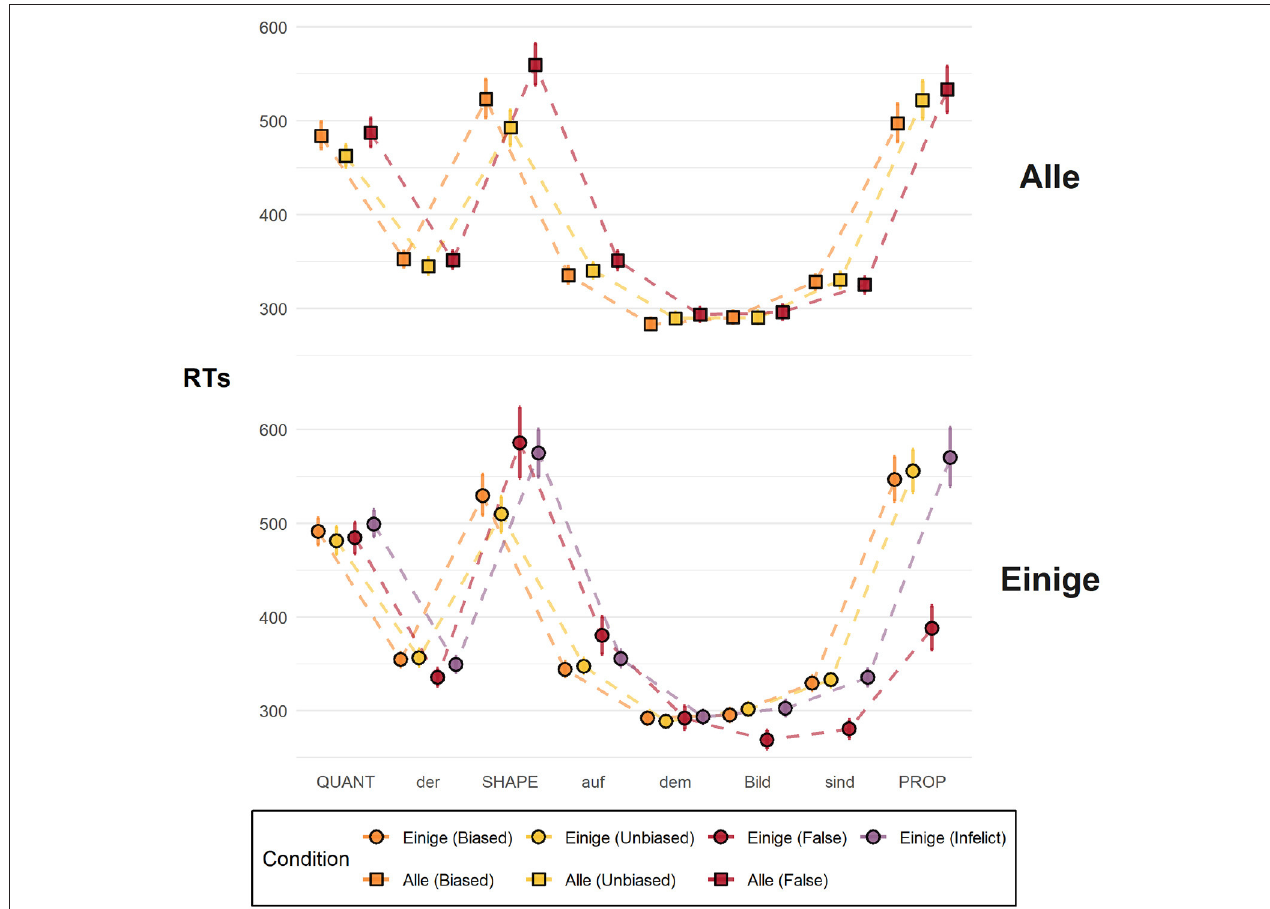
FIGURE 7 | Mean reading times across all sentence regions up until the last critical term. The error bars represent 95% bootstrapped confidence intervals.